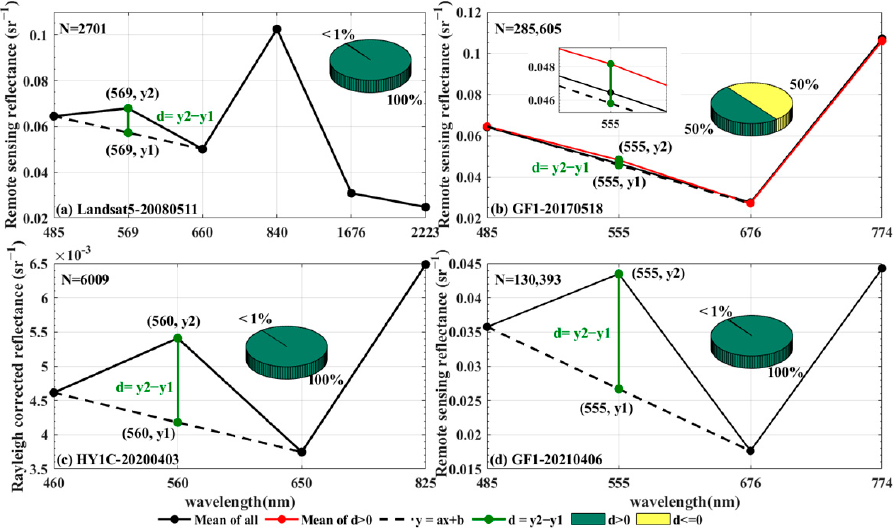
Figure 16. Spectral information of extracted green tide pixels for the source found in the southeastern Yellow Sea (blue box in Figure 6) for 2008, 2017, 2020, and 2021 (where N is the number of pixels). As seen in Error! Reference source not found. , 2015, 2019, and 2021 were the three years with the largest green tide blooms in the Yellow Sea, and it was found that the green tide generally reached its maximum cover area in mid-to-late June to early July, which was consistent with previous studies [44–46]. In addition, the duration of the three years was relatively long, consistent with Zheng et al., 2022. 6. Conclusions For many years, the repeated green tide blooms in the Yellow Sea have not only posed a great threat to the coastal ecology but also caused huge economic losses along the Yellow Sea coast. Therefore, there is an urgent need to predict future blooms of the Yellow Sea green tide to guide appropriate measures to prevent and control these events. In this paper, we propose a semi-automated method for extracting data on the Yellow Sea green tide based on the NDVI , which greatly improved the e ffi ciency of green tide extraction and enabled analysis of the events and monitoring of the green tide in real-time. In this study, we fi rst compared the presentation of the green tide from various RS data sources (GF-1, Landsat 5 TM, Landsat 8 OLI_TIRS, HJ-1A/B, HY-1C, and MODIS). High-resolution RS images were shown to present the sporadic fl oating green algae more completely than low-resolution images, with the resolution being highly positively corre- lated with the completeness of representation of the details. To evaluate the accuracy of the newly proposed semi-automated green tide extraction method, Precision, Recall, and the composite index F1-score were used as indicators. For di ff erent satellites, the mean